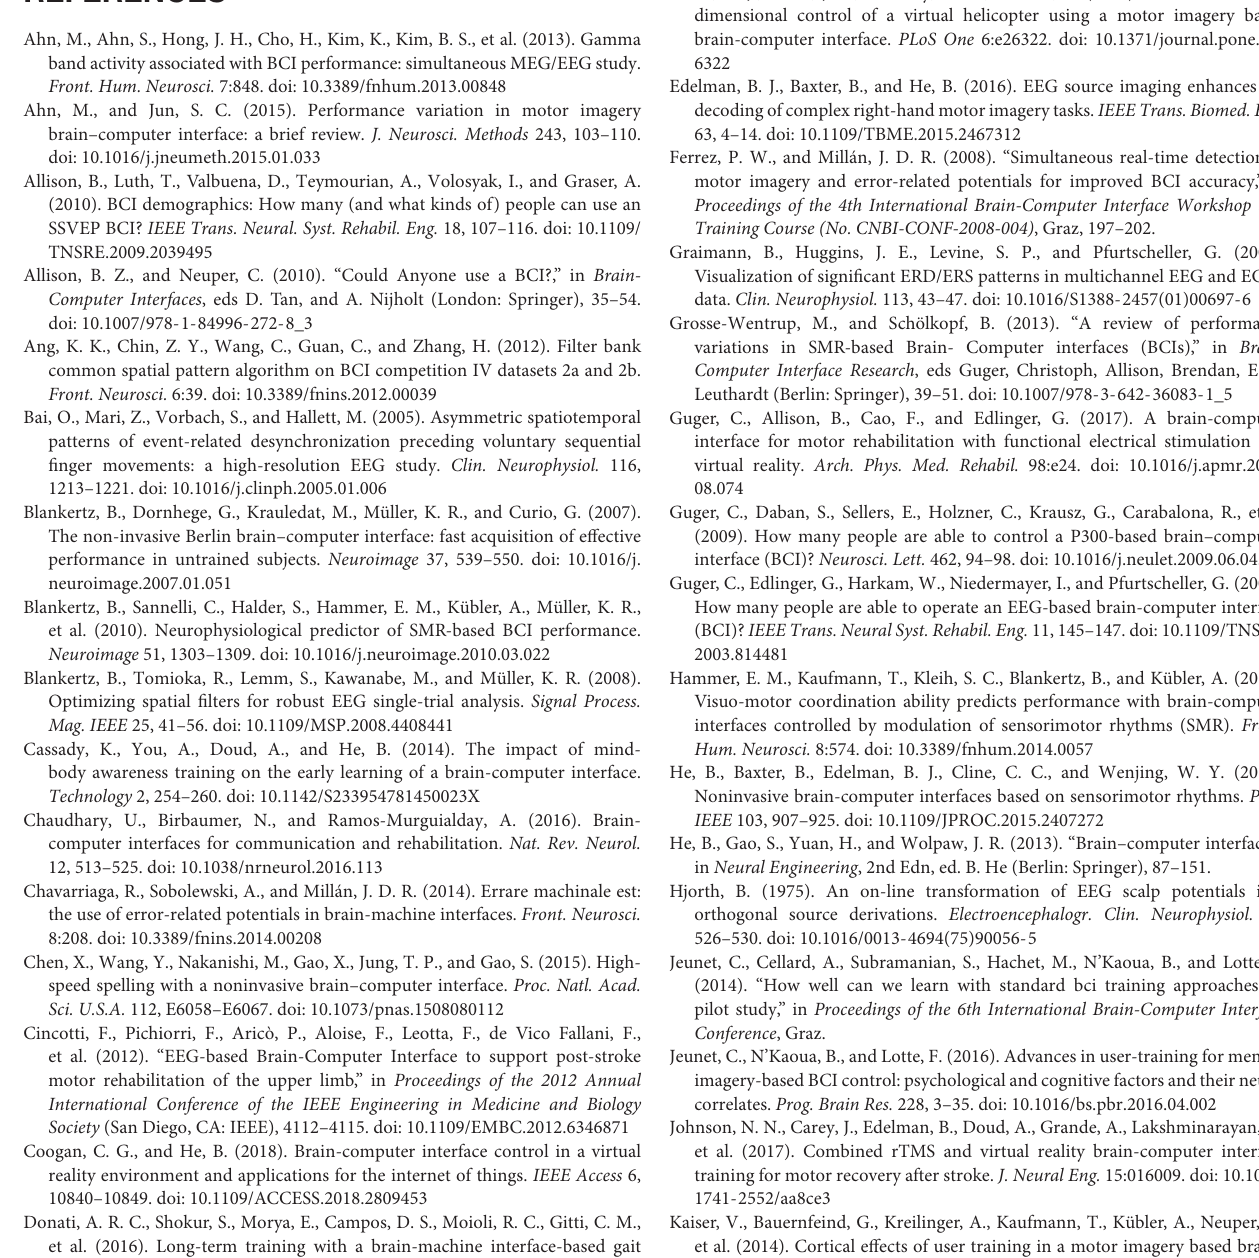
FIGURE S1 | An individual example (Subject 18) of the time varying average ERD/ERS value for the right hand task (the first row) and the left hand task (the second row) across the training sessions. Shown is the similar convention to the group average results. A moderate ERD on the contralateral hemisphere and a very strong ERS on the ipsilateral hemisphere was observed in all of three sessions. FIGURE S2 | An individual example (Subject 34) of the time varying average ERD/ERS value for the right hand task (the first row) and the left hand task (the second row) across the training sessions. Shown is the similar convention to the